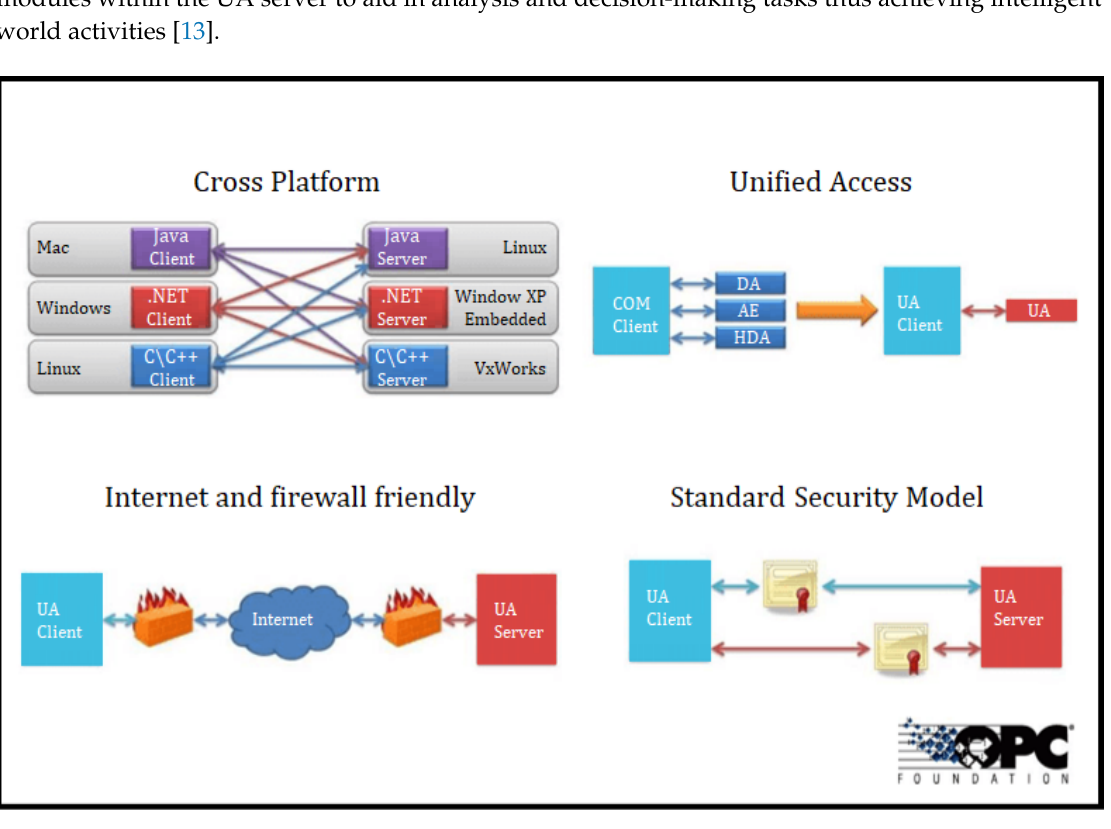
Figure 3. Key features and benefits of the Open Platform Communication-Unified Architecture (OPC-UA) protocol